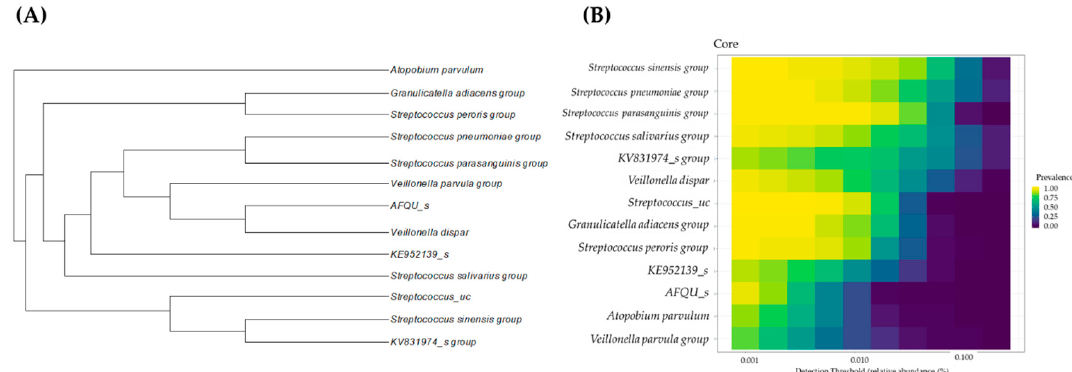
Figure 3. Core visualization: ( A ) phylogenetic tree and ( B ) core heatmap of 13 species detected in all subjects.